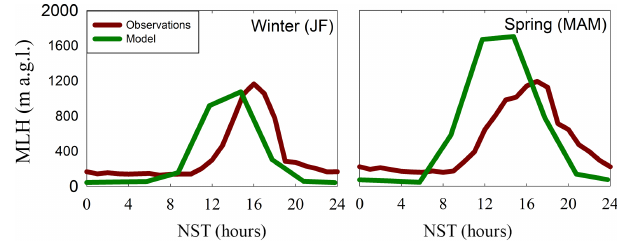
Figure 6. Observed (red) and model-simulated (green) boundary layer height during winter and spring at